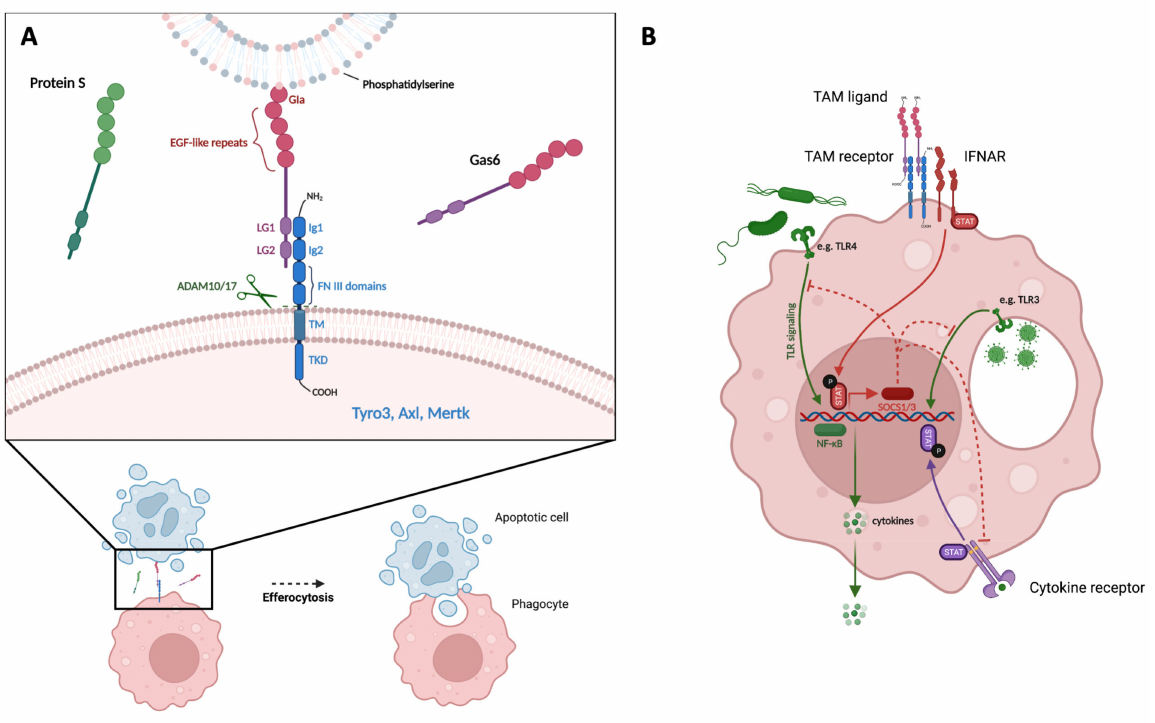
Figure 1. TAM receptors promote efferocytosis and inhibit TLR signaling. ( A ) TAM receptors promote efferocytosis. Illustration of TAM ligand (Gas6) serving as a bridge between PtdSer exposed on the surface of an apoptotic cell and a TAM receptor expressed by a phagocyte. Ligand G1a domain binds PtdSer on apoptotic cell; LG domains of ligand bind to Ig domains of TAM receptor; ADAM10/17 cleave TAM receptor at cleavage sites within TM domain. ( B ) TAM receptors inhibit TLR signaling. Illustration of TAM ligand binding and activation of TAM receptor, interaction with IFNAR/STAT complex, transcription of SOCS1/3, inhibition of TLR- and cytokine receptor- signaling pathways, and reduction in NF- κ B-induced pro-inflammatory cytokine production. PtdSer = Phosphatidylserine, EGF = epidermal growth factor, LG = laminin G, Ig = immunoglobulin- like, FNIII = fibronectin type III, ADAM10/17 = A Disintegrin and metalloproteinase domain- containing protein 10/17, TM = transmembrane, TKD = tyrosine kinase domain, IFNAR = type I interferon receptor, TLR = toll-like receptor, SOCS1/3 = suppressors of cytokine signaling 1 and 3, STAT = signal transducer and activator of transcription, NF- κ B = nuclear factor kappa-light-chain- enhancer of activated B